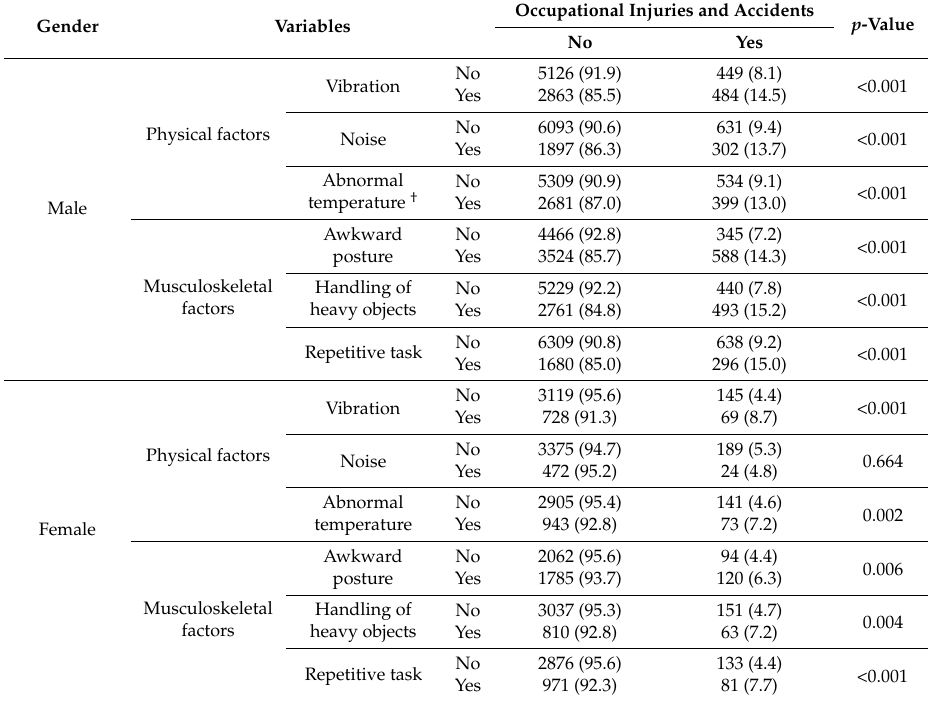
Table 2. Differences in the prevalence of occupational injuries and accidents among the two genders based on physical and musculoskeletal